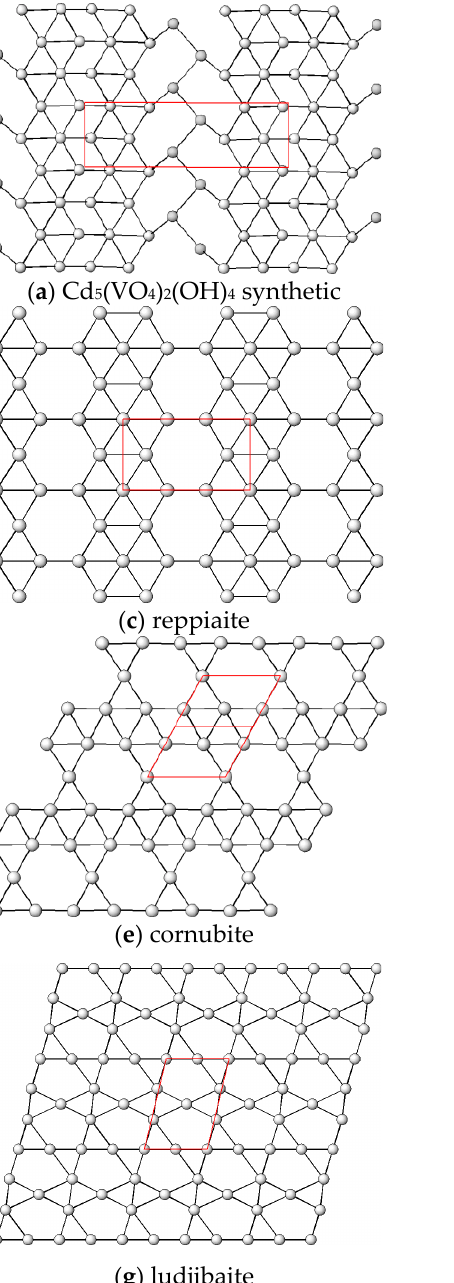
Figure 4. The nodal representation (nodes symbolize M O 6 octahedra) of different topologies observed in M 5 ( X O 4 ) 2 (OH) 4 compounds. The solid lines represent M ··· M interatomic distances shorter than 4 Å. A trace of the unit cell is drawn for reference (red). The projection ( a ) along the c -axis direction in synthetic Cd 5 (VO 4 ) 2 (OH) 4 (Cd1O 6 octahedra are grey); ( b ) along the b -axis direction in synthetic Cd 5 (VO 4 ) 2 (OH) 4 (The similar metal wavy layers were found in arsenoclasite, Mn 5 (AsO 4 ) 2 (OH) 4 , gatehouseite, Mn 5 (PO 4 ) 2 (OH) 4 , as well as in synthetic Co 5 (PO 4 ) 2 (OH) 4 ); ( c ) along a -axis in reppiaite, Mn 5 (OH) 4 (VO 4 ) 2 ; ( d ) along [0 ⎯ 1 ⎯ 1 ] in turanite, Cu 5 (OH) 4 (VO 4 ) 2 ; ( e ) along [01 ⎯ 1 ] in cornubite, Cu 5 (AsO 4 ) 2 (OH) 4 ; ( f ) along a -axis in pseudomalachite, Cu 5 (PO 4 ) 2 (OH) 4 and cornwallite, Cu 5 (AsO 4 ) 2 (OH) 4 ; ( g ) along a -axis in ludjibaite, Cu 5 (PO 4 ) 2 (OH) 4 ; ( h ) along c -axis in reichenbachite, Cu 5 (PO 4 ) 2 (OH) 4 .